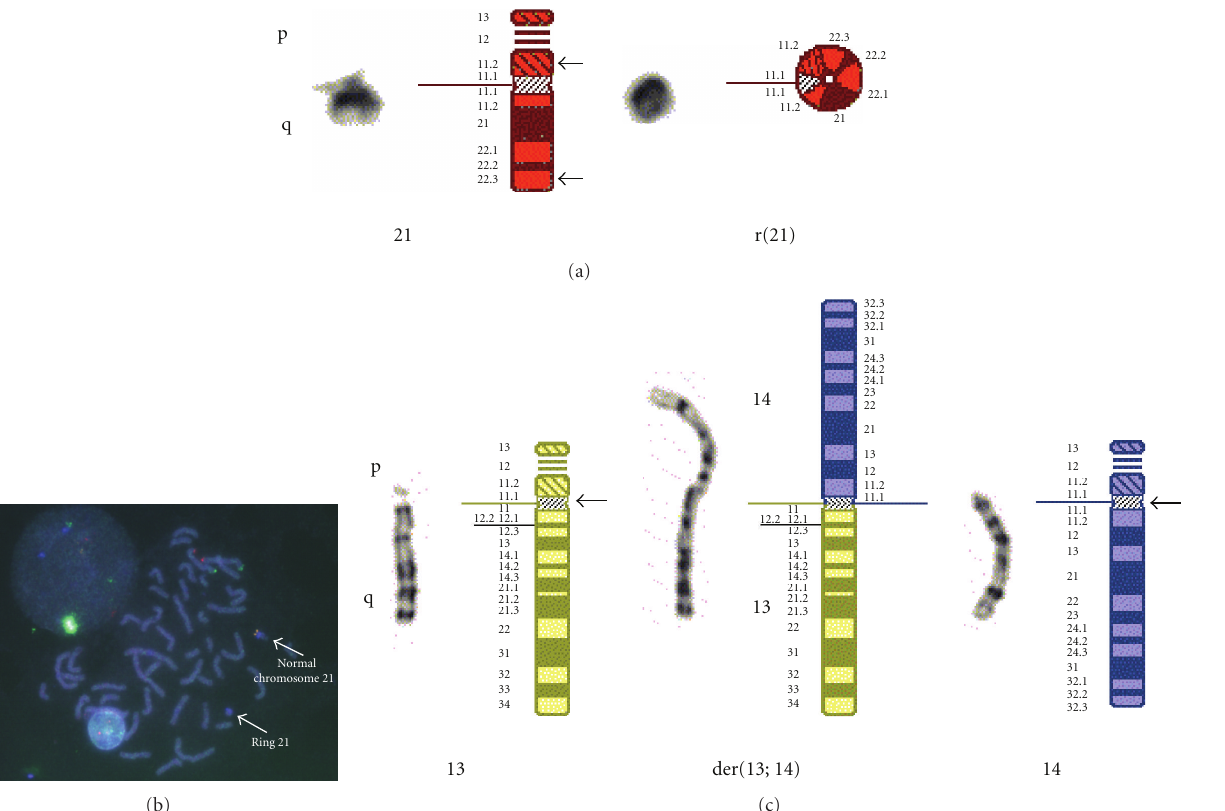
Figure 1: Normal chromosome homologues and relevant rearranged chromosomes in proband and parents; (a) shows the normal and ring chromosomes 21 of the proband; (b) Is a FISH image showing loss of telomeres on the r(21); (c) Shows the Robertsonian translocation chromosome detected in the proband’s